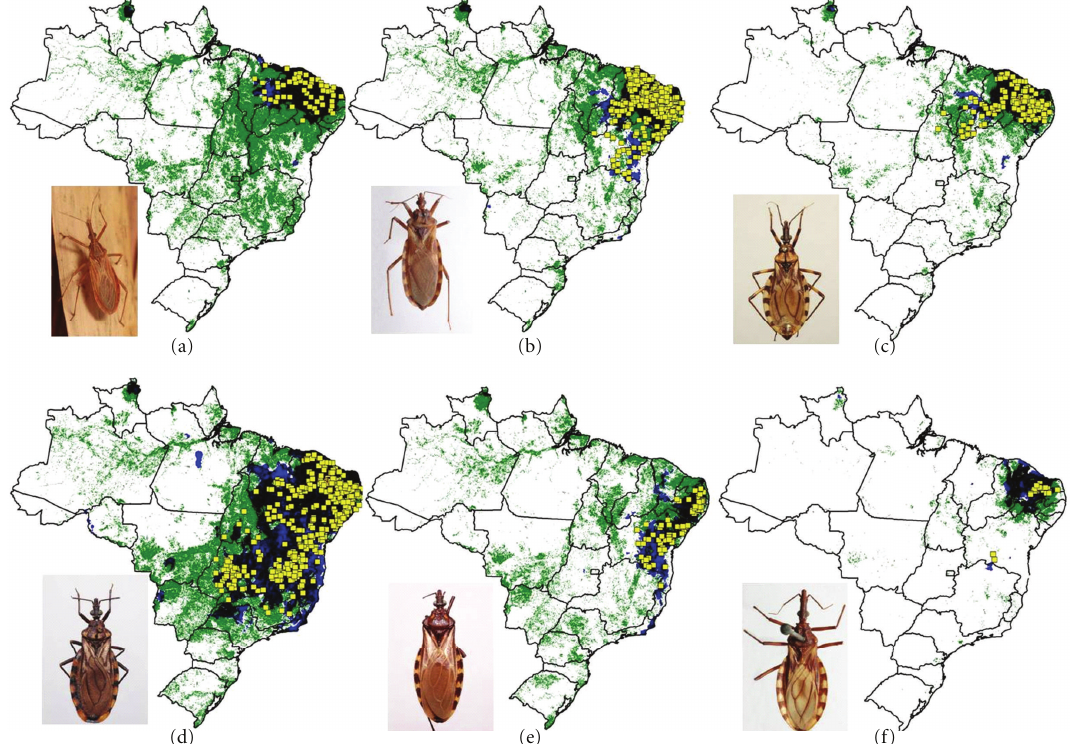
Figure 4: Ecological niche models projected as potential distributions for triatomine species in northeastern Brazil. (a) R. nasutus, (b) P.